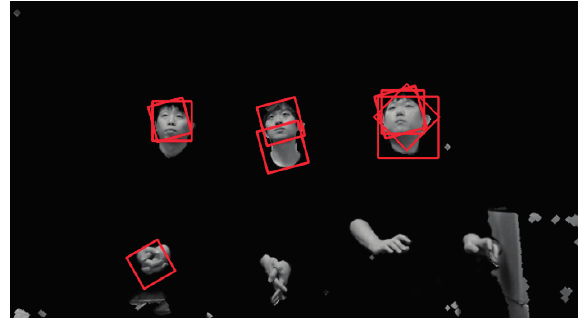
Figure 9. Chosen face boxes of Figure 7 using the GLDH method.